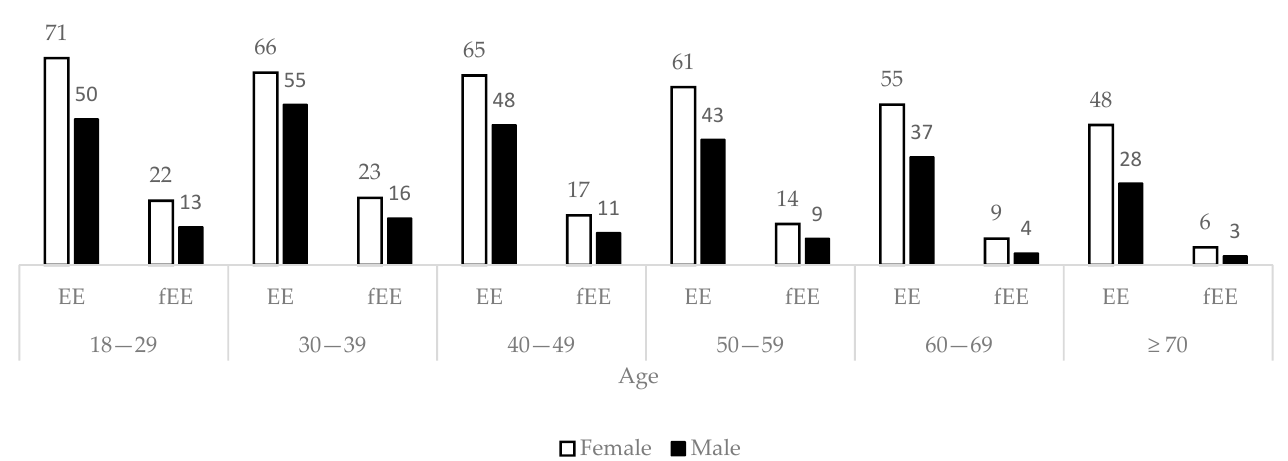
Figure 1. Proportions (%) of the participants reporting any degree of emotional eating (EE) and frequent emotional eating (fEE) among females (white) and males (black) in different age groups. Differences were determined to be statistically significant by means of a Pearson´s Chi Square test ( p < 0.05). fEE = EE ≥ 5 times/week.